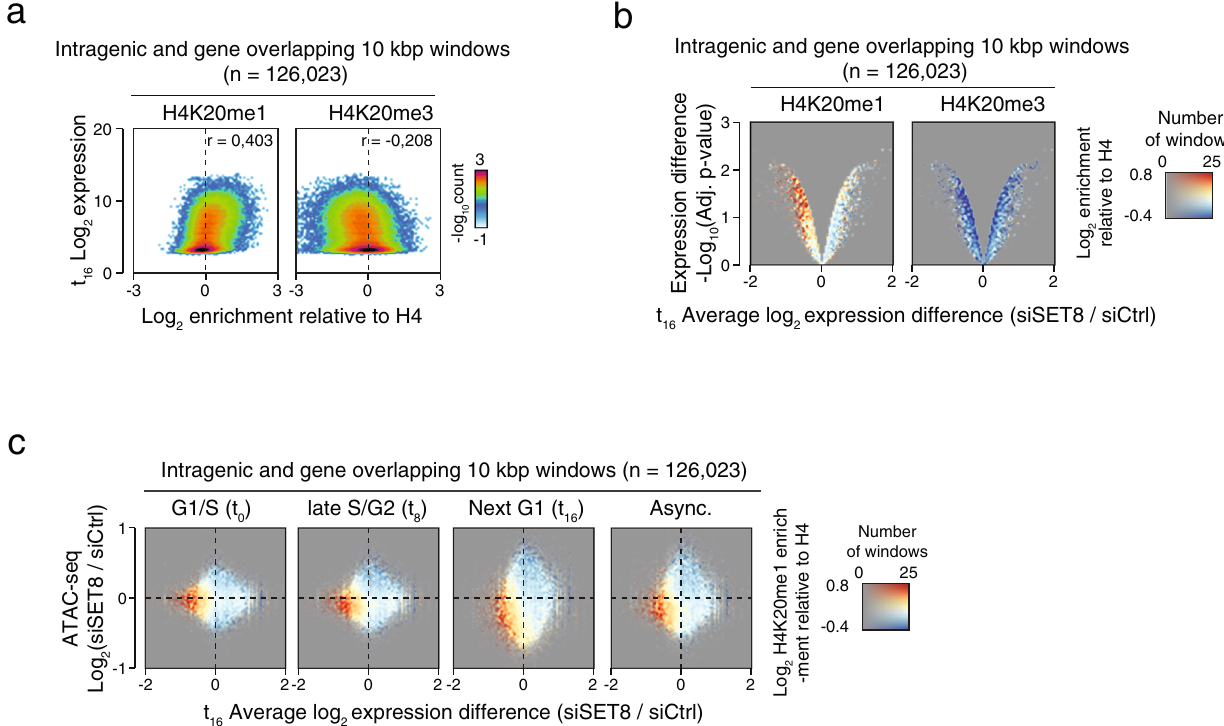
Fig. 3 The SET8-H4K20me1 pathway driven chromatin accessibility promotes transcription. a 2D-histograms showing the relationship between enrichment of selected H4K20 methylation states ( X -axes) and expression assayed by microarrays ( Y -axis) at human genes. X -axes shows log 2 normalized H4K20me1 (left side) or H4K20me3 (right side) ChIP-seq levels relative to the levels of H4 control ChIP-seq, while Y -axes shows log 2 - transformed expression levels from synchronized U2OS cells 16 h (G1 phase) after release. The color scales re fl ect the number of windows having a certain combination of K20me enrichment and expression. r -values shows the Pearson ’ s correlation coef fi cients for the data in each plot. b Colored volcano plots showing the three-way relationship between enrichment of selected H4K20 methylation states (color), gene expression difference ( X -axis), and signi fi cance of the gene expression differences ( Y -axis). Coloring shows log 2 normalized H4K20me1 (left side) or H4K20me3 (right side) ChIP-seq levels relative to the levels of H4 control. The opacity in the diagram is controlled by the number of genes having the combination of X -axis and Y -axis values as indicated in the right-side color scale. X -axes show log 2 -transformed difference between SET8-kd over control-kd, and Y -axes show – log 10 adjusted p - values from the analysis of the differential expression from two replicates of SET8-kd and three replicates of control-kd in synchronized U2OS cells analysed at 16 h (G1 phase) after release. c Colored 2D-histograms showing the genome-wide three-way relationship between enrichment of H4K20me1 (color), expression changes ( X -axis), and ATAC-seq signal changes in SET8-kd over control-kd in synchronized U2OS. ChIP-seq and ATAC-seq signal was measured in 10 kbp windows that overlapped fully or partially with an annotated gene body. ATAC-seq signal and expression differences are plotted the log 2 difference between SET8-kd over control-kd. Coloring shows the average log 2 normalized H4K20me1 ChIP-seq levels relative to the levels of H4 control ChIP-seq as indicated in the right-side color scale. Opacity re fl ects the number of windows with a certain combination of expression change ( Y - axis) and ATAC-seq change ( X -axis) controlling opacity as indicated in the right-side color scale. Plots shows FPKM-normalized ATAC-seq signal from separate rounds of experiments as follows: synchronized U2OS cells at G1/S (0 h — top, three replicates), S-G2 (8 h — middle, three replicates) and next G1 phase (16 h — bottom, four replicates), or U2OS cells grown asynchronously (rightmost, four